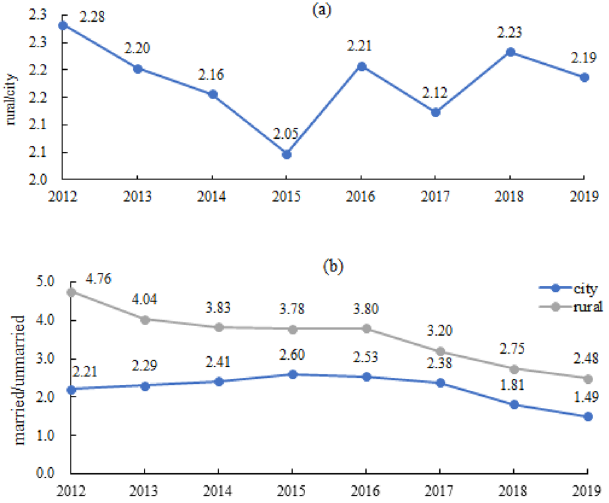
Figure 1. Changes in adolescent pregnancies in the ratio of rural to urban areas ( a ) and ratio of married women to unmarried women ( b ) in